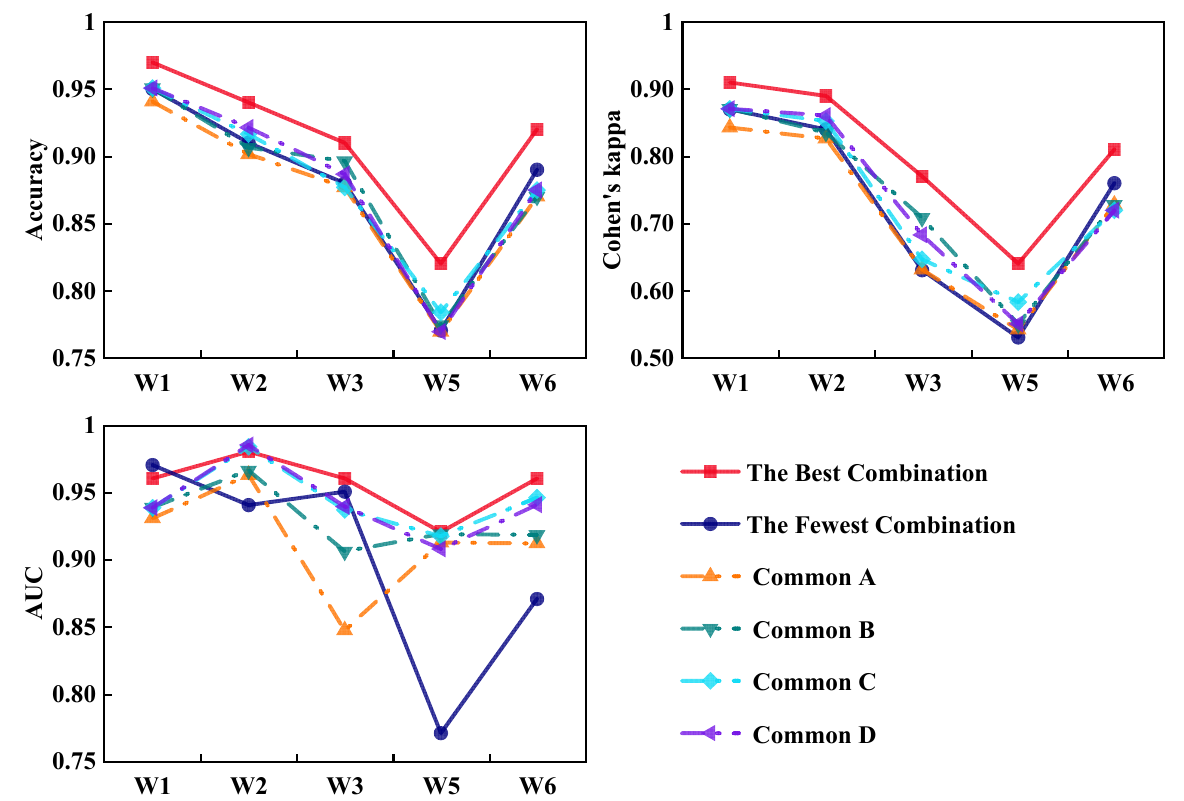
Figure 14. The prediction power of the best combination, fewest combination, and common combi- nations.